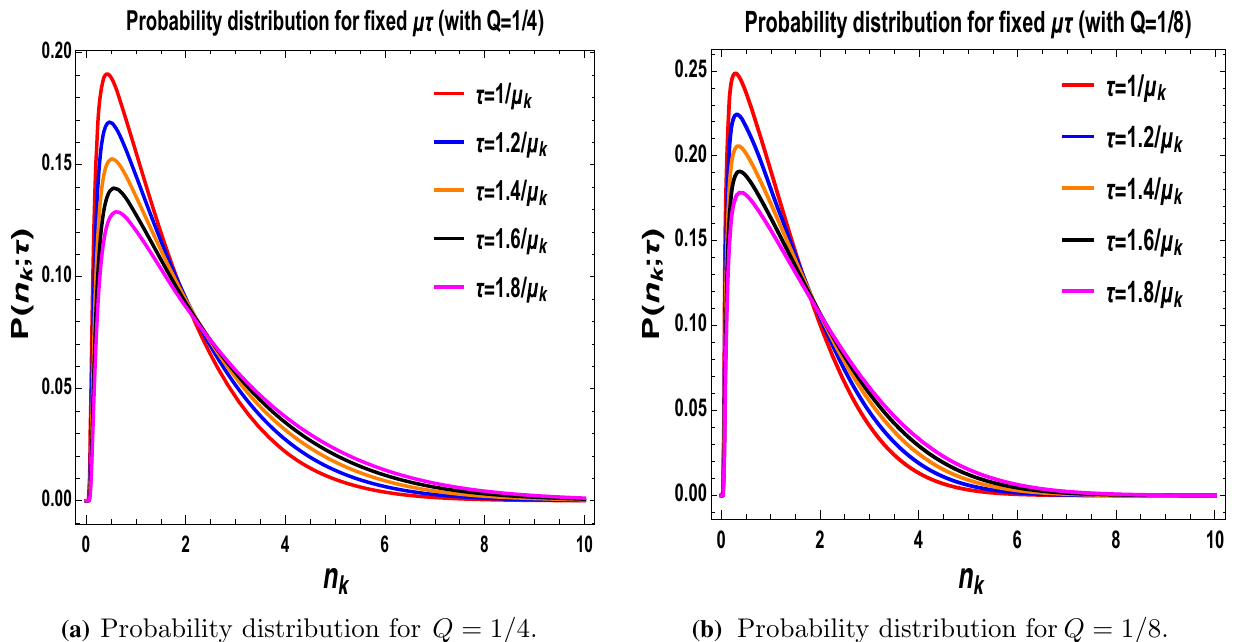
Fig. 57 Evolution of the probability density function for generalized prescription with respect to the occupation number per mode n , for a fixed